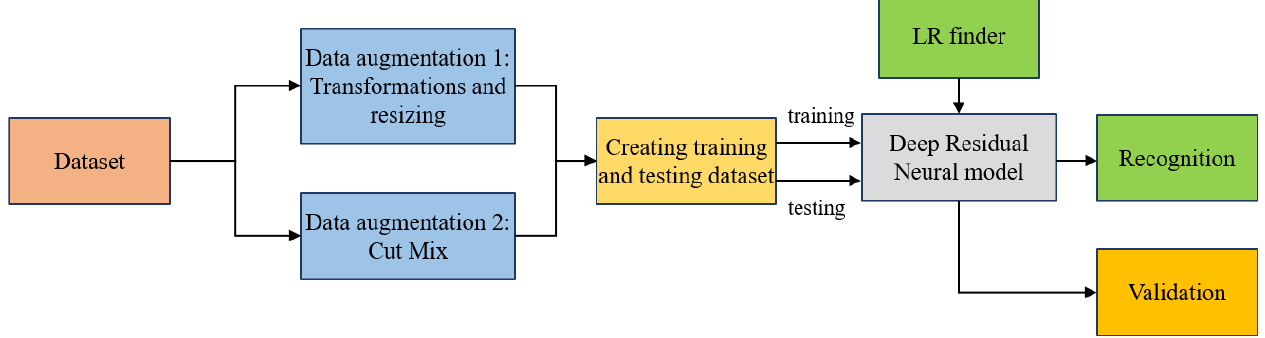
Figure 17. Workflow for the tomato leaf disease recognition system.